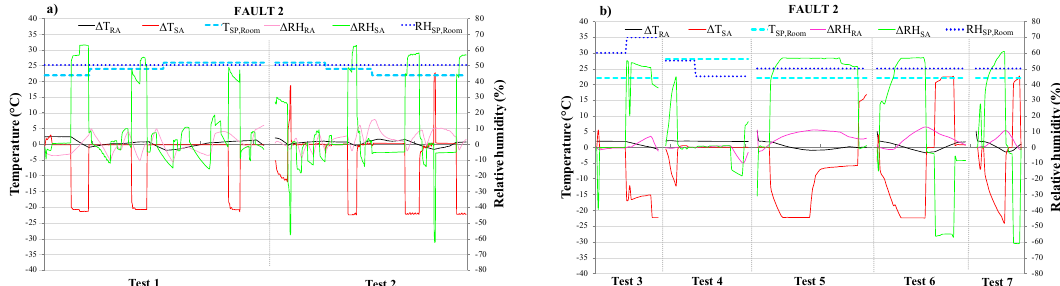
Figure 8. Comparison between normal operation and operation with fault 2: test 1, 2 ( a ), test 3, 4, 5, 6, 7 ( b ).